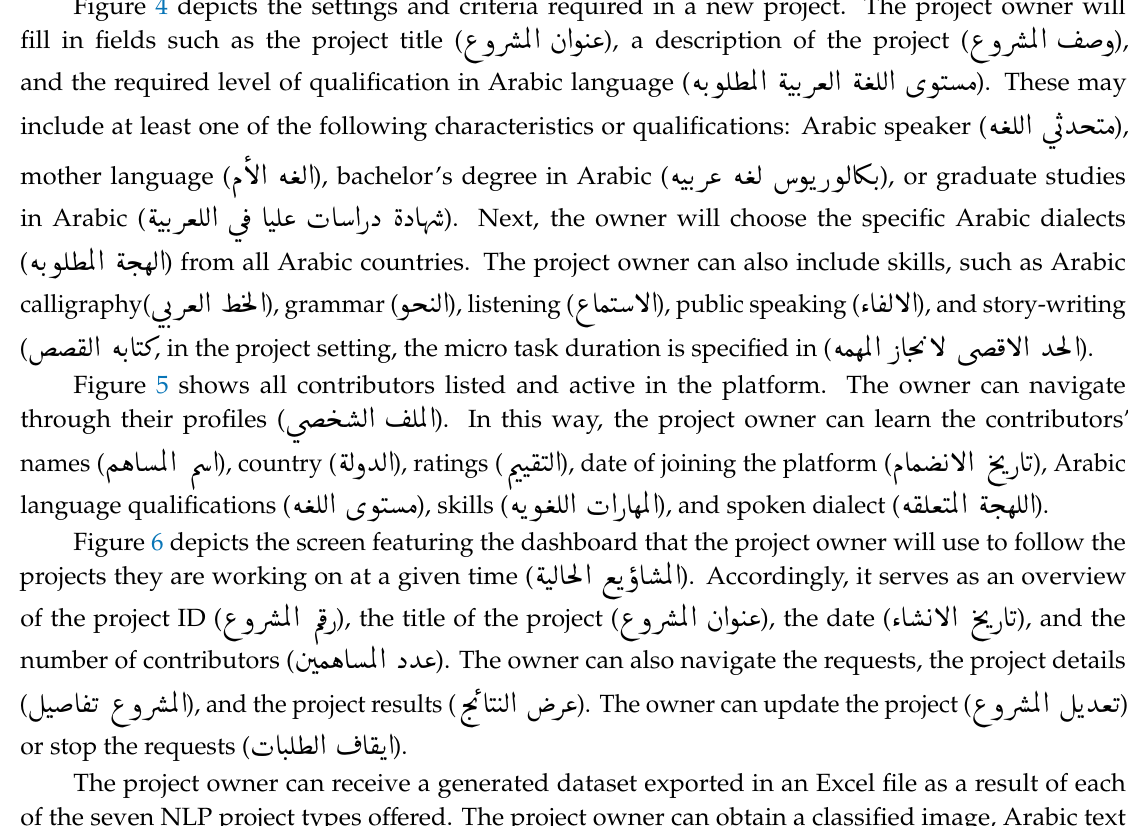
Figure 6. Project dashboard.